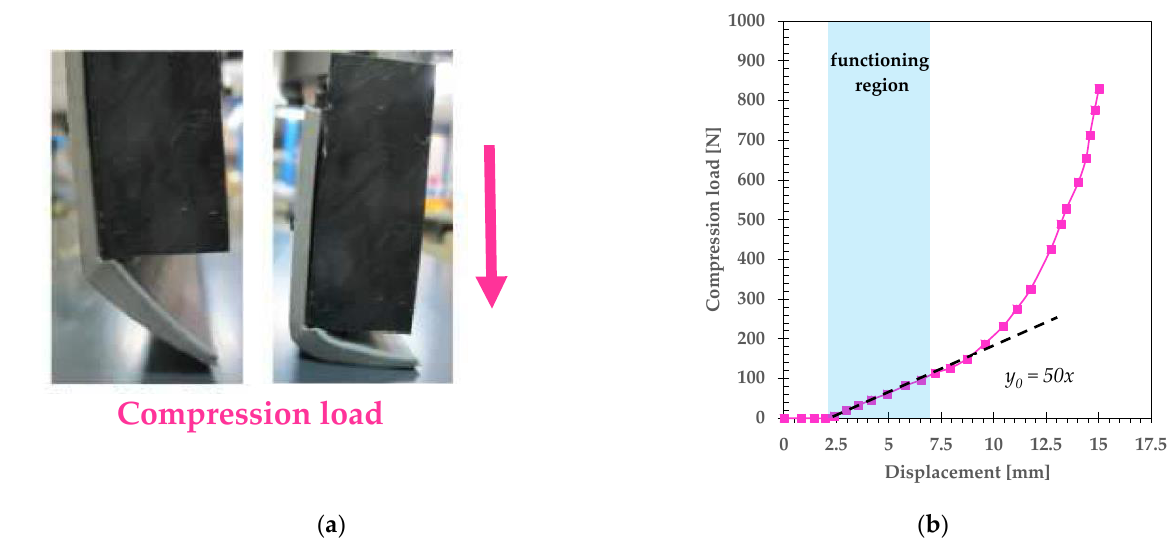
Figure 9. Stiffness characterization of leap seal: ( a ) compression test; ( b ) linear ( K seal = 50 N/mm) and nonlinear loading curves.